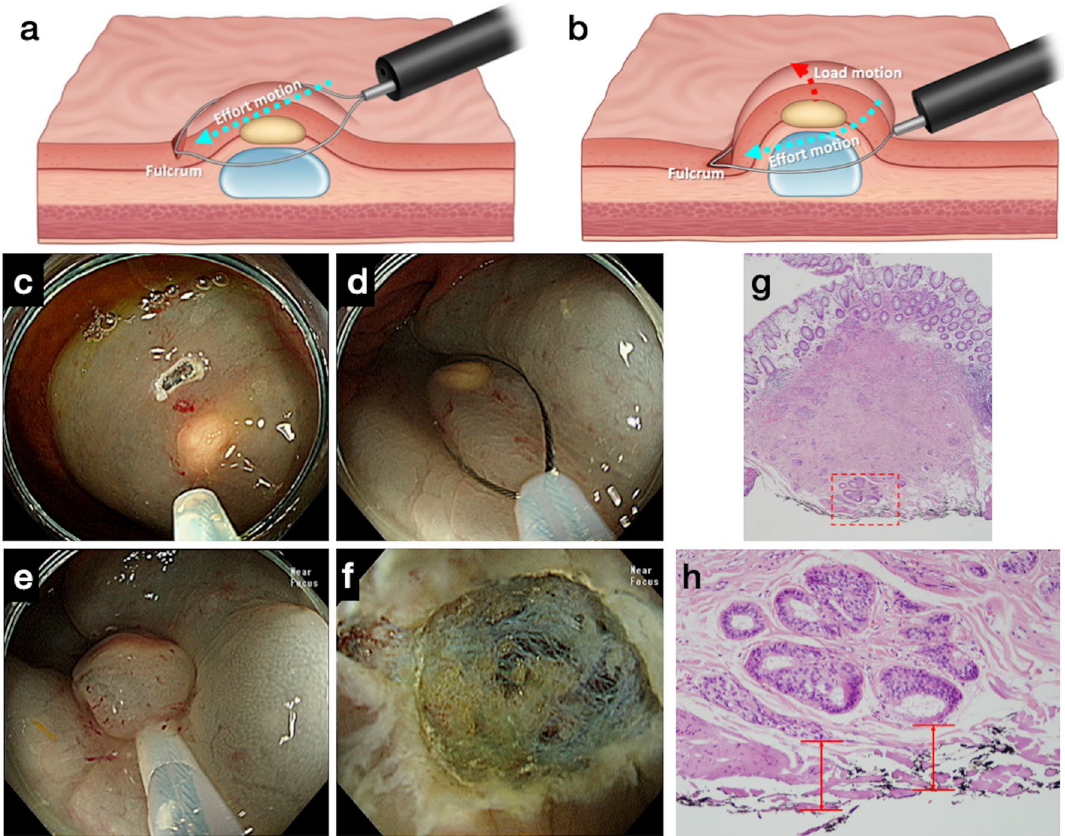
Figure 2. Principles of anchored snare-tip endoscopic mucosal resection for a suspected or established rectal neuroendocrine tumor (NET). ( a ) The snare-tip is anchored into the mucosal incision site on the oral side of the lesion. The anchoring point works as a fulcrum for leverage while the snare-tip is gently pressed toward the direction indicated by the cyan dotted arrow (effort motion). ( b ) The NET will rise slightly toward the luminal side (red dotted arrow) because of a load motion resulting from the leverage effect. The anchoring should be maintained by pressing the snare-tip toward the mucosal incision site while tightening the snare (continued effort motion toward the direction indicated by the cyan dotted arrow). During snaring, the snare sheath can be pressed downward to ensure en bloc snaring (see the curved tail part of the cyan dotted arrow). ( c ) A mucosal incision was made on the oral side of the lesion. ( d ) The snare was anchored while being opened. ( e ) Anchoring was well maintained until en bloc snaring was completed. ( f ) En bloc complete resection was possible. ( g ), ( h ) The deep safety resection margin was measured after endoscopic